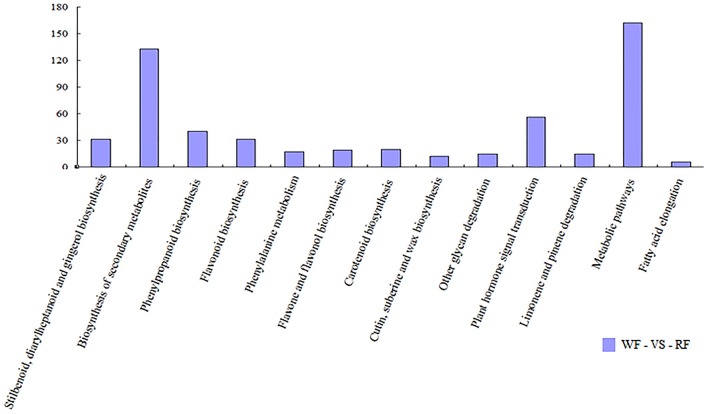
Histogram showing pathway categories and the numbers of gene in each pathway, respectively.